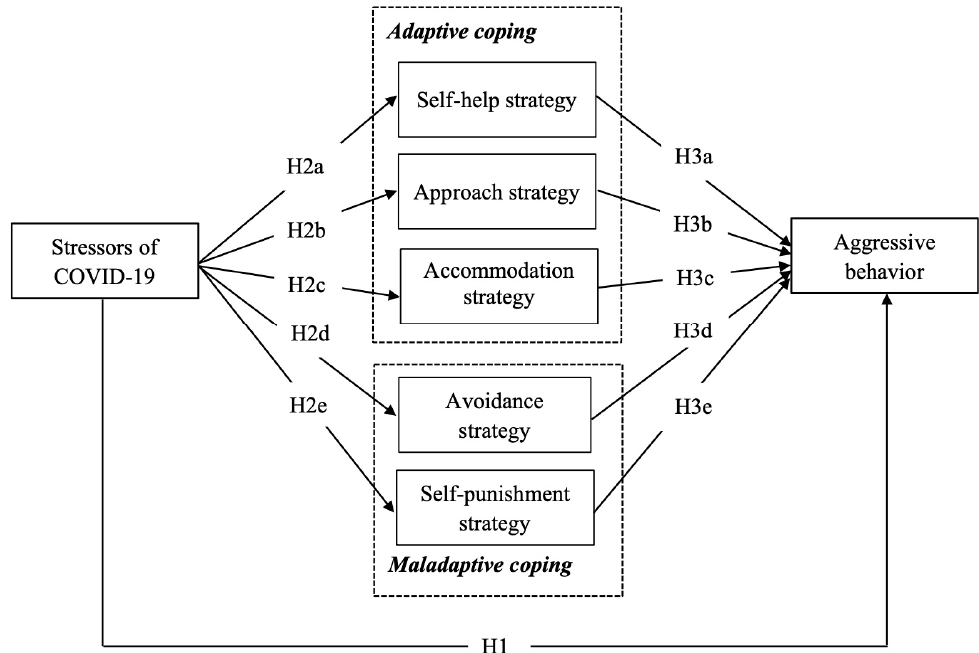
Figure 1. The hypothetical model of the direct and indirect effects in the present study.